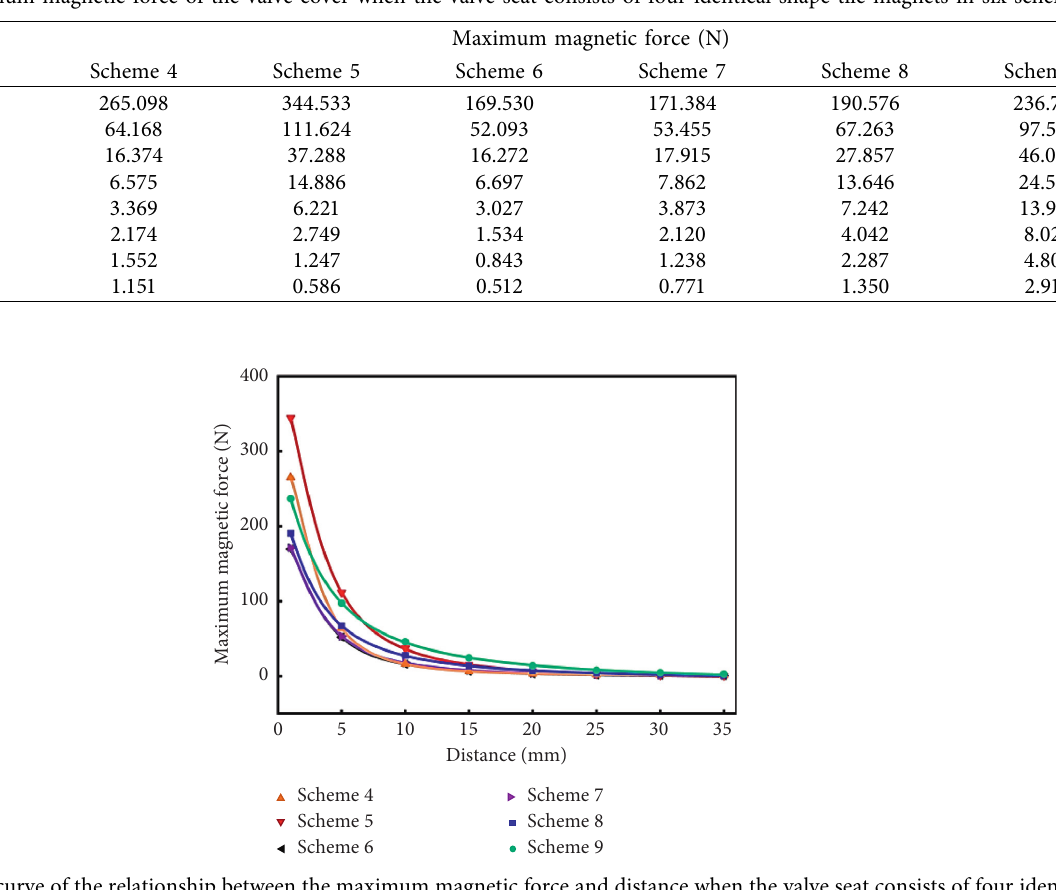
Table 2: Maximum magnetic force of the valve cover when the valve seat consists of four identical shape tile magnets in six schemes.